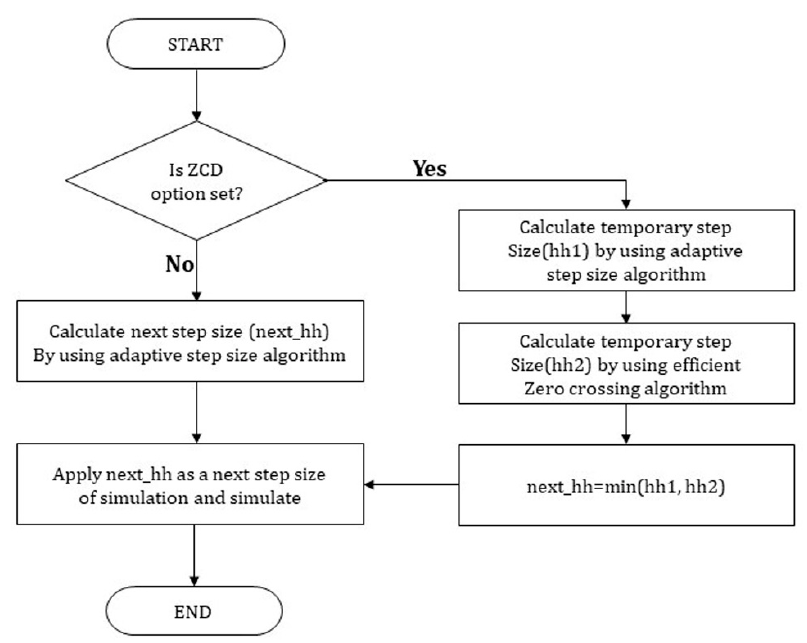
Figure 6. Sequence diagram of the redundancy reduction algorithm.